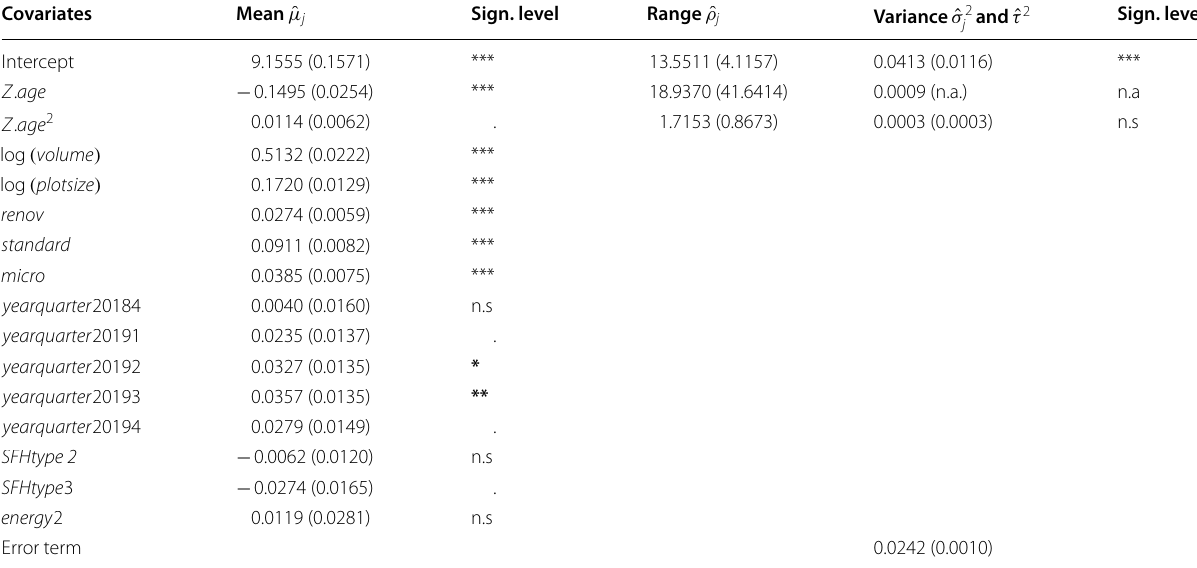
The corresponding estimates’ standard errors are given in parenthesis. In most cases, the standard errors can be approximated and computed by the Hessian from the numeric optimization. For the mean and the variance estimates, we use a two-sided Z- and a Wald-test to test whether ˆ µ j �= 0 and ˆ σ 2 j > 0 , respectively. This is only possible if the standard error is